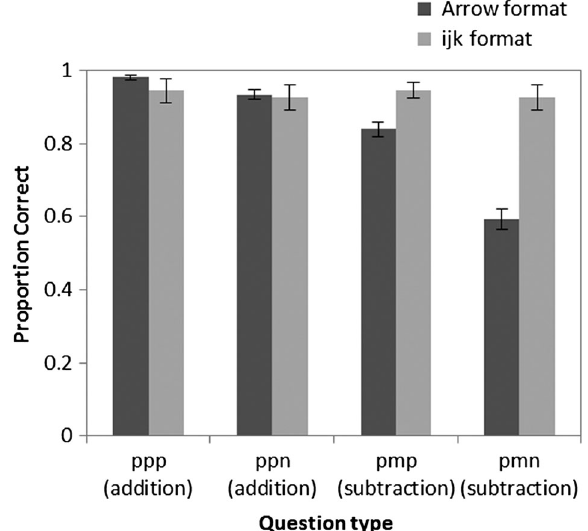
FIG. 2. Student performance on one-dimensional vector ques- tions (see Fig. 1). Scores were high for all question types in the ijk format. Scores were lower for subtraction questions, especially for subtraction of opposing vectors ( pmn ). Error bars indicate (cid:2) 1 standard error